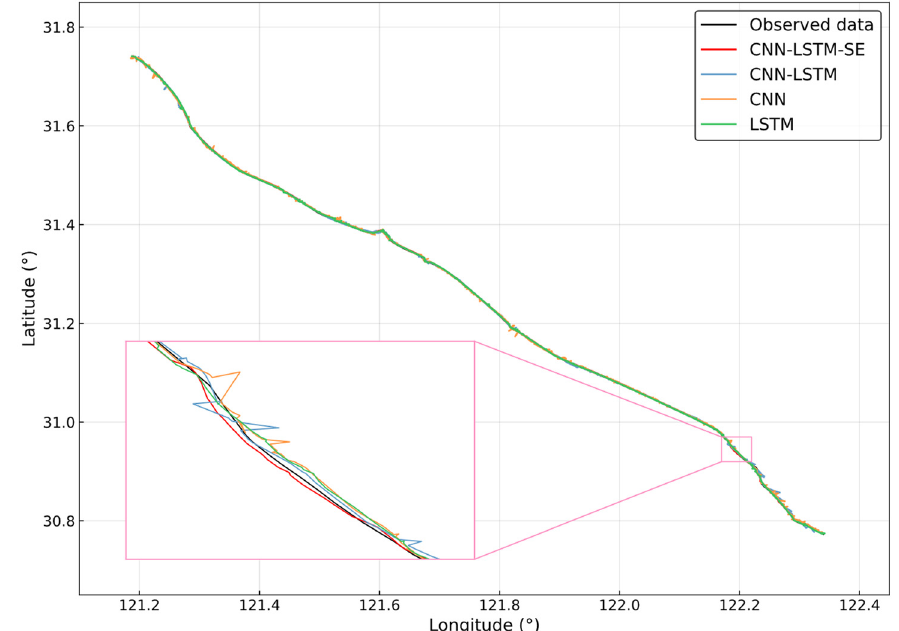
Figure 8. Performance of prediction models for ship-2 with a time interval of 10 s .